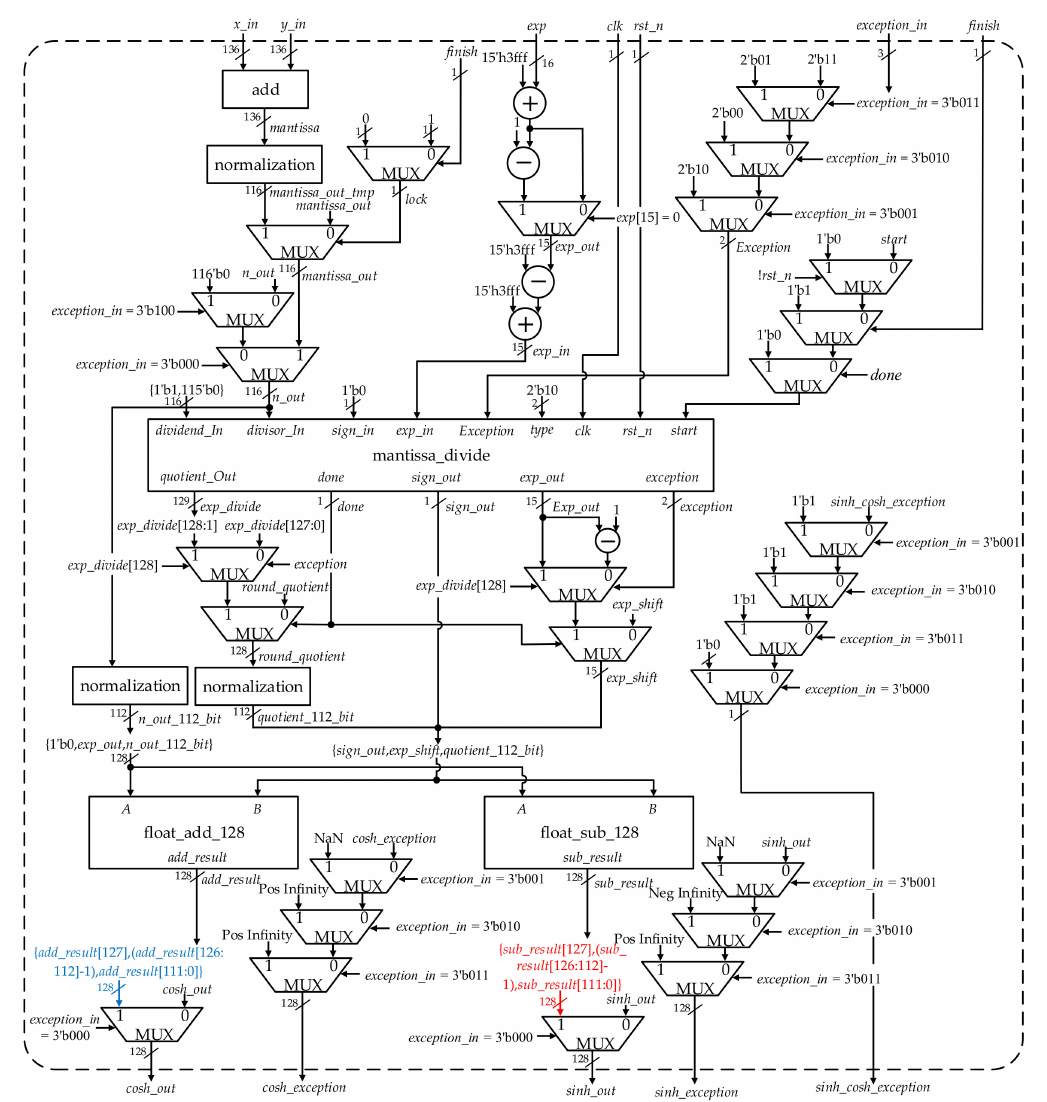
Figure 9. General architecture of Module